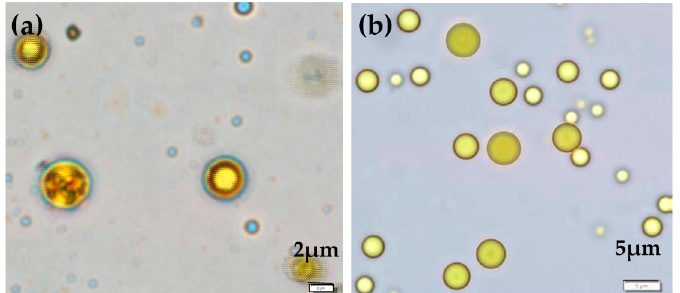
Figure 1. Micrographs show the configuration of ( a ) cross-linked curcuminoids microcapsules (CPM) and ( b ) non-cross-linked CPM.